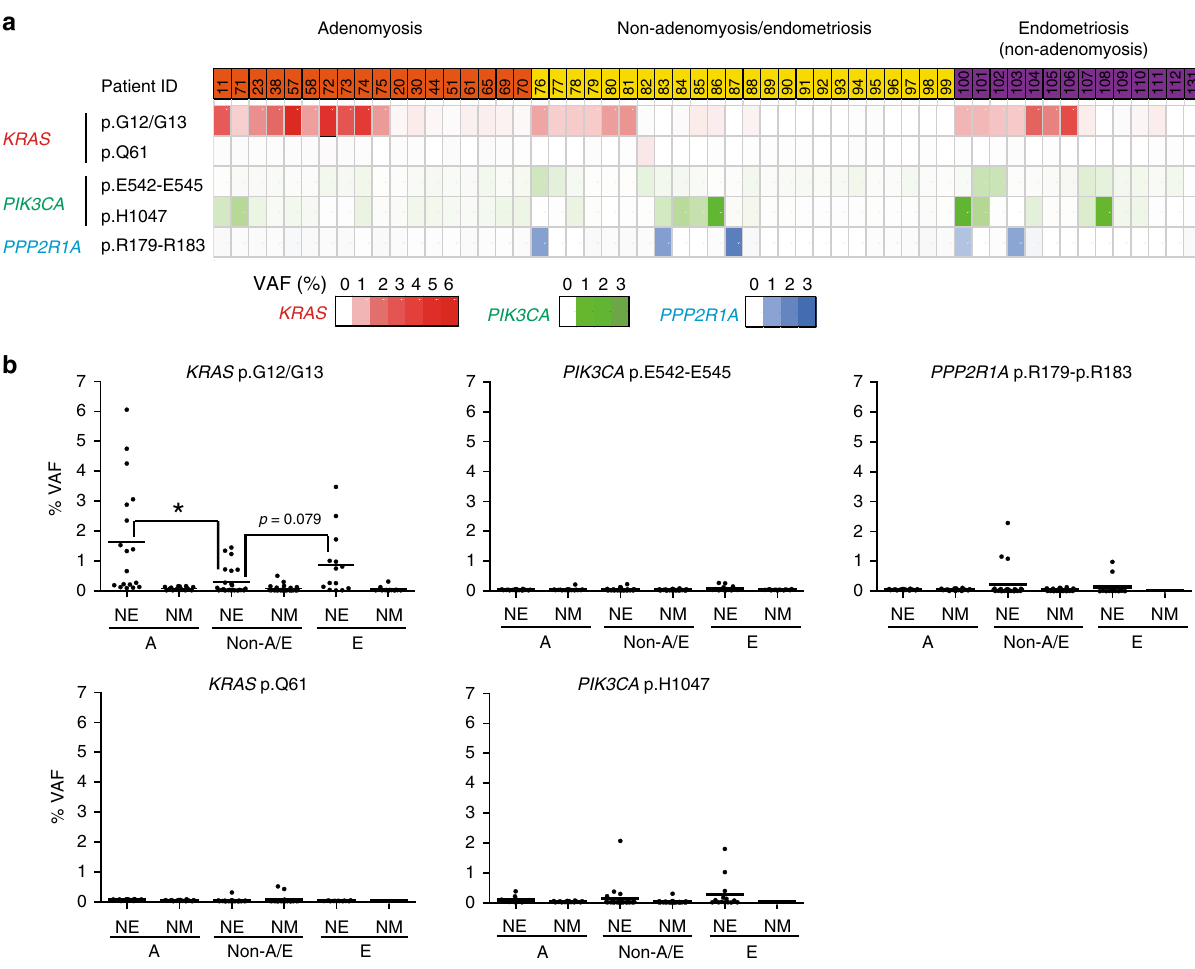
Fig. 5 Increased mutation frequency and VAF of KRAS -mutated clones in the histologically normal endometrium adjacent to adenomyotic or endometriotic lesions. a , b Histologically normal myometrium (NM; negative control) and endometrium (NE) were macro-dissected from the indicated three groups of patients. a Occurrence of the indicated gene mutations in NE of patients with adenomyosis (patient ID column: orange), patients with neither adenomyosis nor endometriosis (patient ID column: yellow), and patients with endometriosis but without co-occurring adenomyosis (patient ID column: purple). Bottom boxes: each box represents an individual mutation of KRAS (red), PIK3CA (turquoise), or PPP2R1A (blue). VAF values are shown using individual color scales. b Quanti fi cation of VAF values as determined by TDS of the indicated mutations in the macro-dissected NM (negative control) or NE from the patients in the group A (adenomyosis; orange in a ), group Non-A/E (patients with neither adenomyosis nor endometriosis; yellow in a ), and group E (patients with endometriosis but without co-occurring adenomyosis; purple in a ). Source data are provided as a Source Data fi le. Data are values for individual patients plus the mean. * p < 0.05 by Welch ’ s